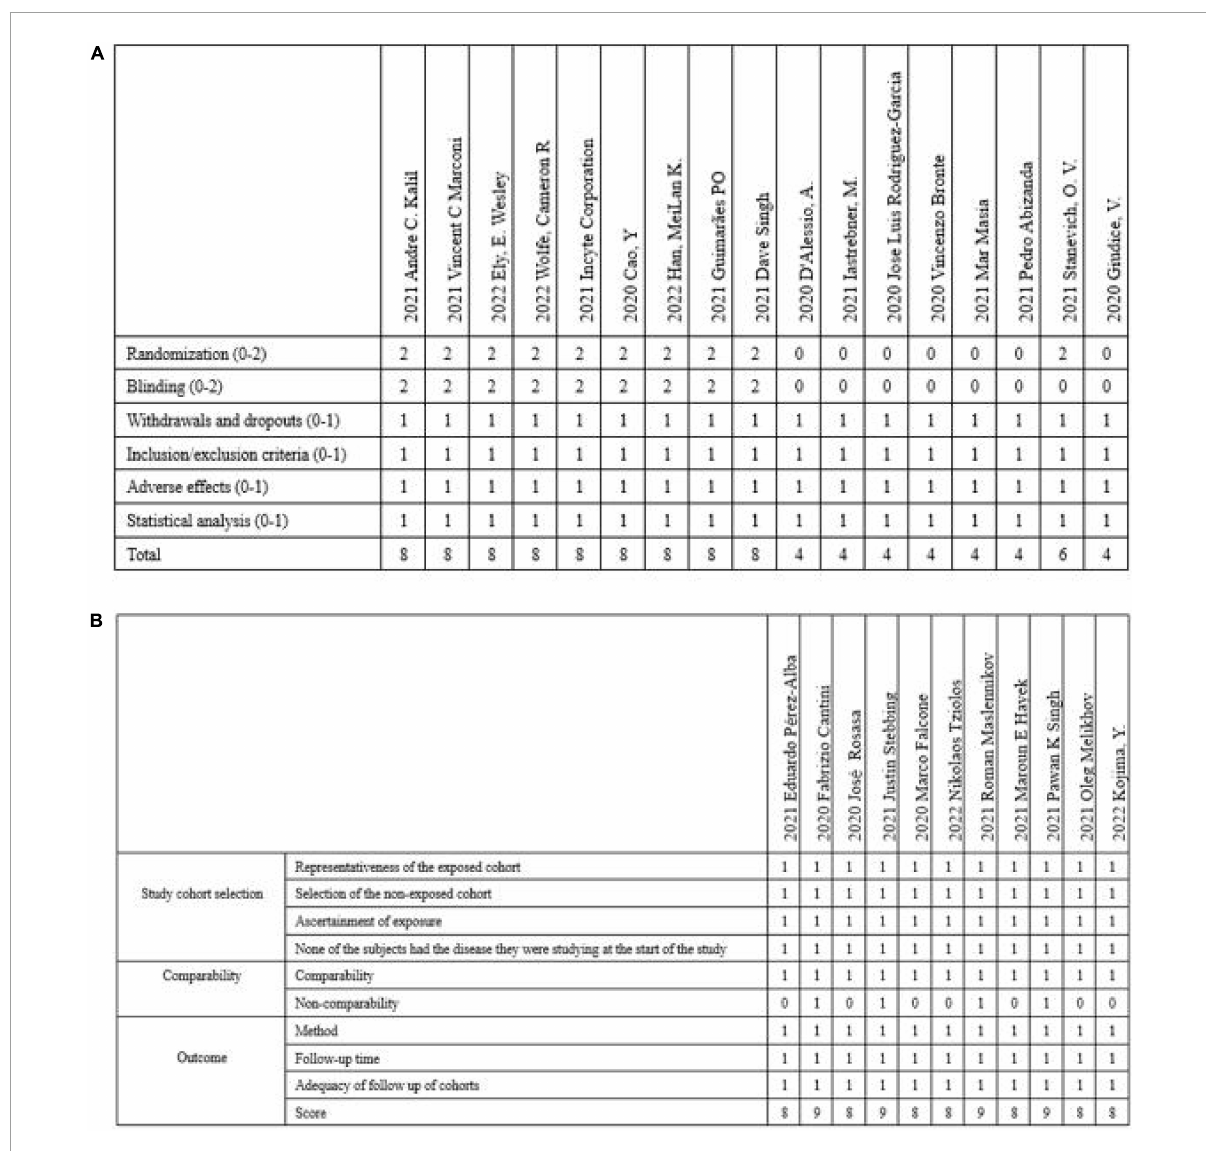
FIGURE2 The quality assessment for these studies included in the article. (A) Modified Jadad score was used to score RCTs and clinical trials included. (B) NOS score was used to score observational studies. RCTs, randomized clinical trials; NOS, Newcastle–Ottawa